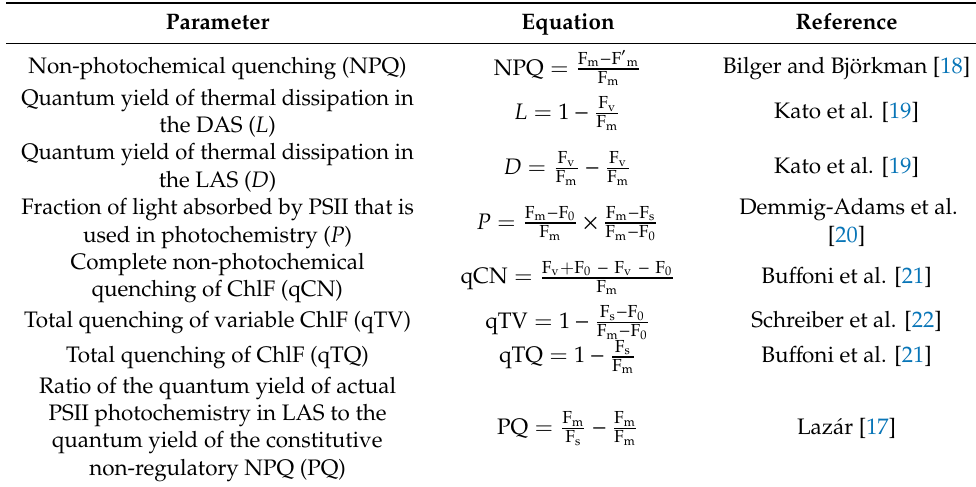
Table 1. Summary of commonly used concepts of chlorophyll fluorescence parameters referring to the